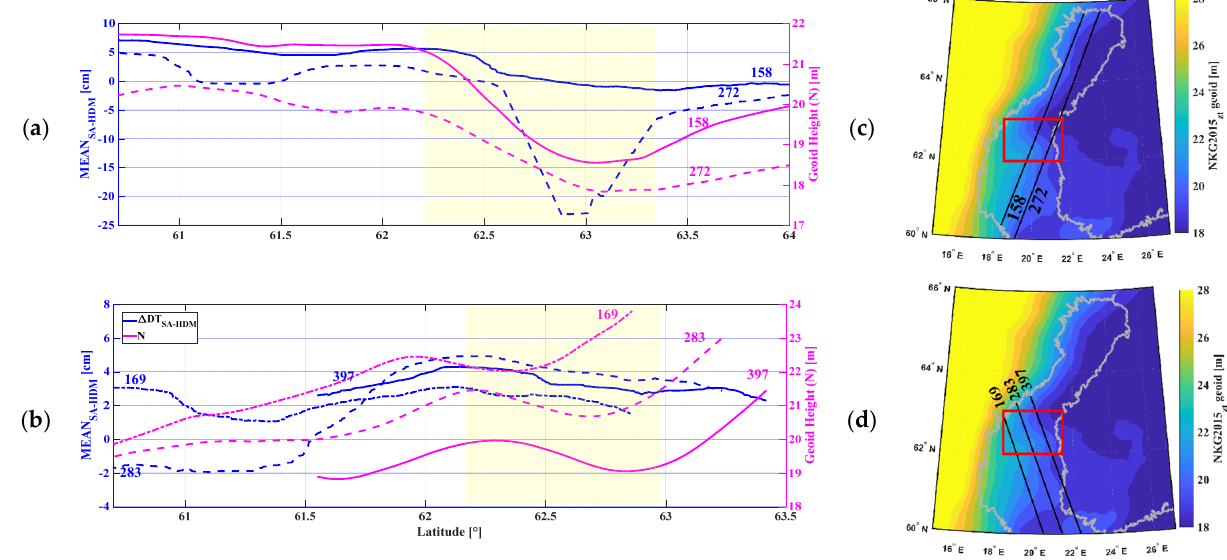
Figure 11. The averaged MEAN SA − HDM during 2017–2019 over the Gulf of Bothnia of S3A for two descending ( a ) and three ascending passes ( b ), denoted in blue lines. The geoid undulations along the passes are denoted in magenta-color lines (the different line styles represent each pass). The yellow masked area is the location of steep geoid slopes, which may cause deteriorations in ∆ DT SA − HDM . The locations of yellow masked areas in the left-hand-side profiles are denoted by red rectangles in the right-hand-side maps ( c , d ), whereas the NKG2015 geoid model is in the background. Note that for pass#272 the drastic drop at 63 ◦ is most likely due to land contamination.